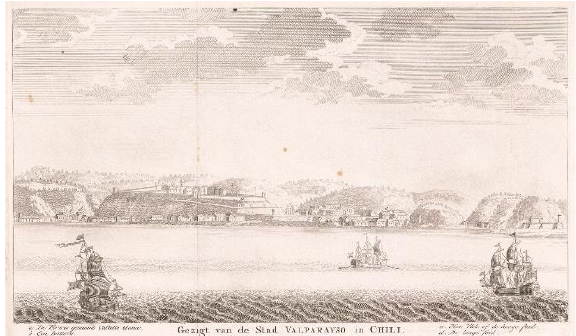
Figure 13. View of the bay of Valparaíso with Castillo San José in the background. Author: Isaak Tirion, 1766.